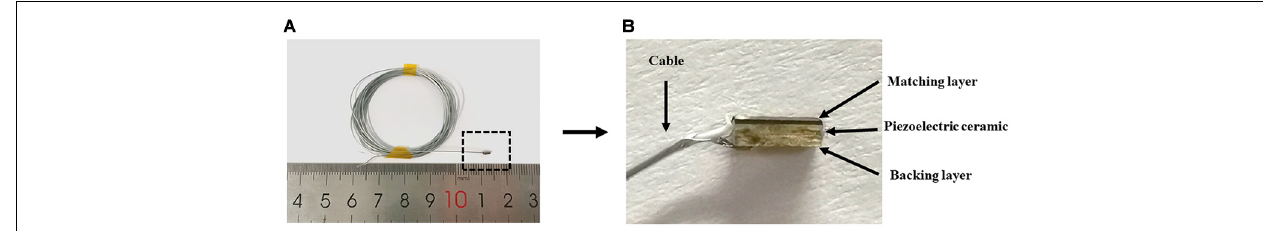
FIGURE 5 | (A) the complete transducer (B) the detail of